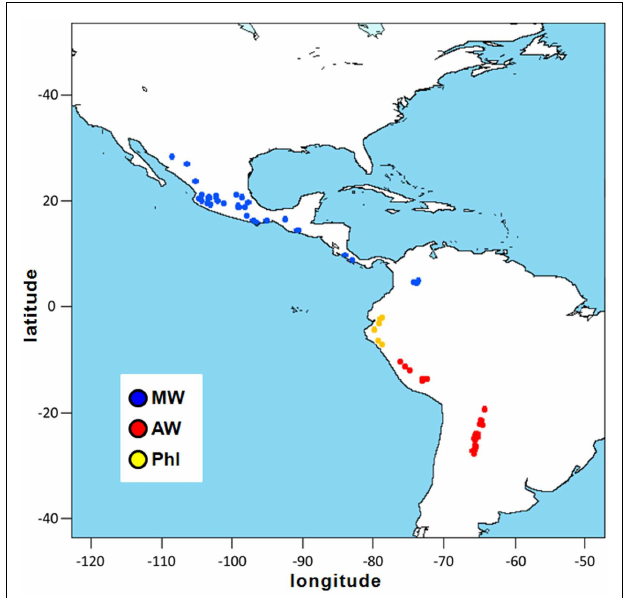
FIGURE 1 | Geographical distribution of the P. vulgaris accessions used in the present study. Latitude and longitude are expressed in the Universal Transverse Mercator system. MW, Mesoamerican wild; AW, Andean wild; PhI, northern Peru and